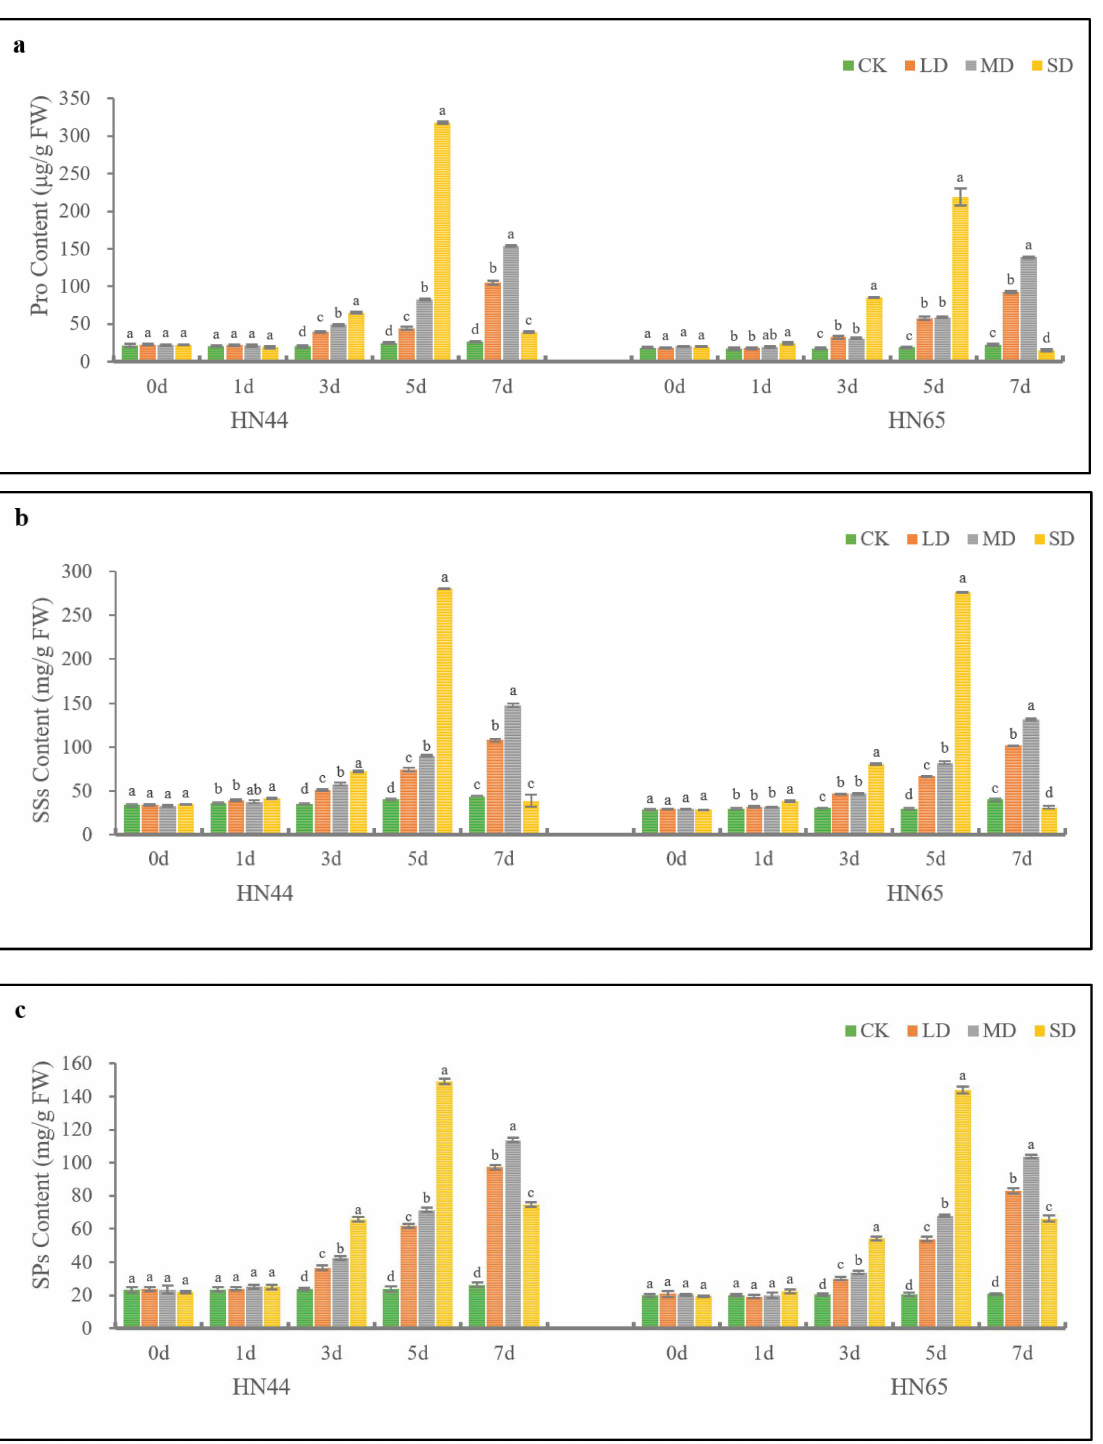
Figure 3. Changes in Pro ( a ), SSs ( b ) and SPs ( c ) contents with time in HN44 and HN65 under different drought levels. Different letters in treatments indicate significant differences according to Duncan’s single factor variance test at the 5% level, and data are presented as mean ± SE (standard error) ( n =